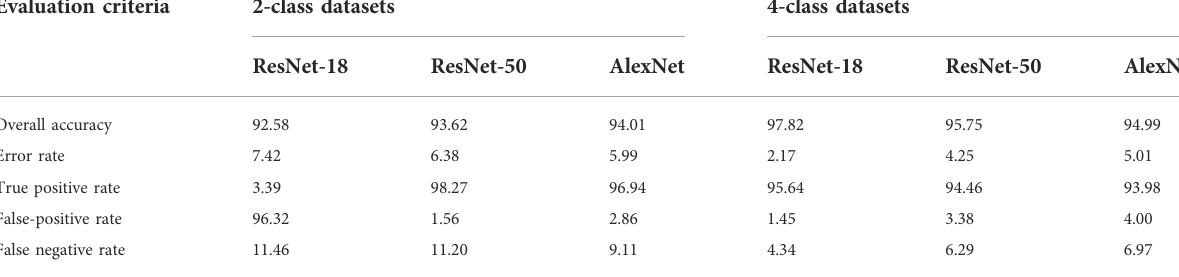
TABLE 1 Performance analysis of the CNN pretrained network in each class dataset. Evaluation